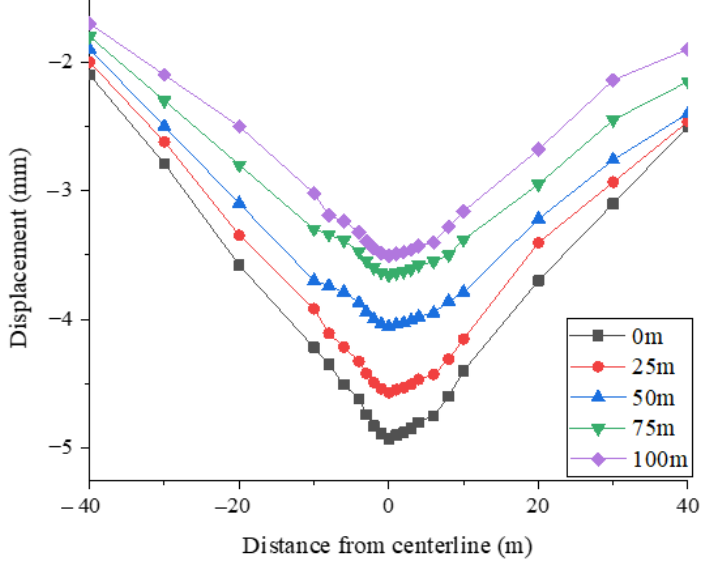
Figure 5. Lateral variation curve of ground settlement for different tunneling surface spacing at 10 m depth in excavation direction.